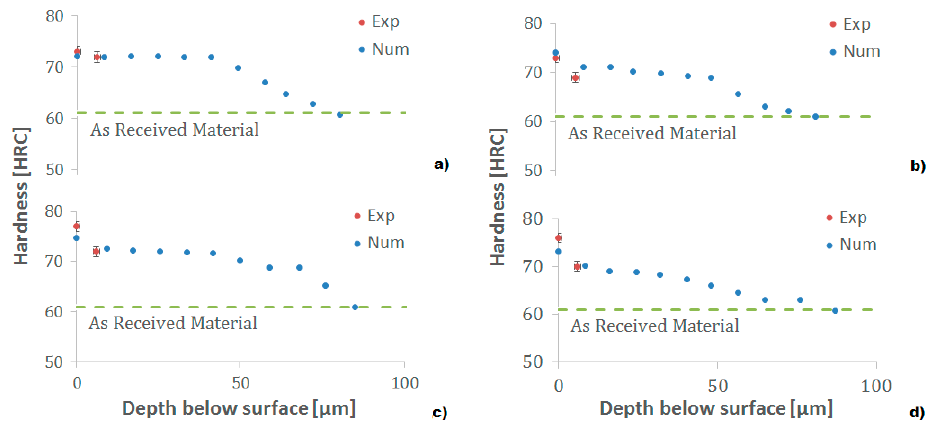
Figure 10. Hardness profile prediction: a) NH-F/V = 91m/min, b) NH-W/V = 91m/min, c) NH-F/V